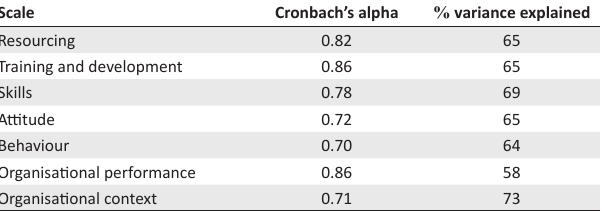
TABLE 2: Cronbach’s alpha.